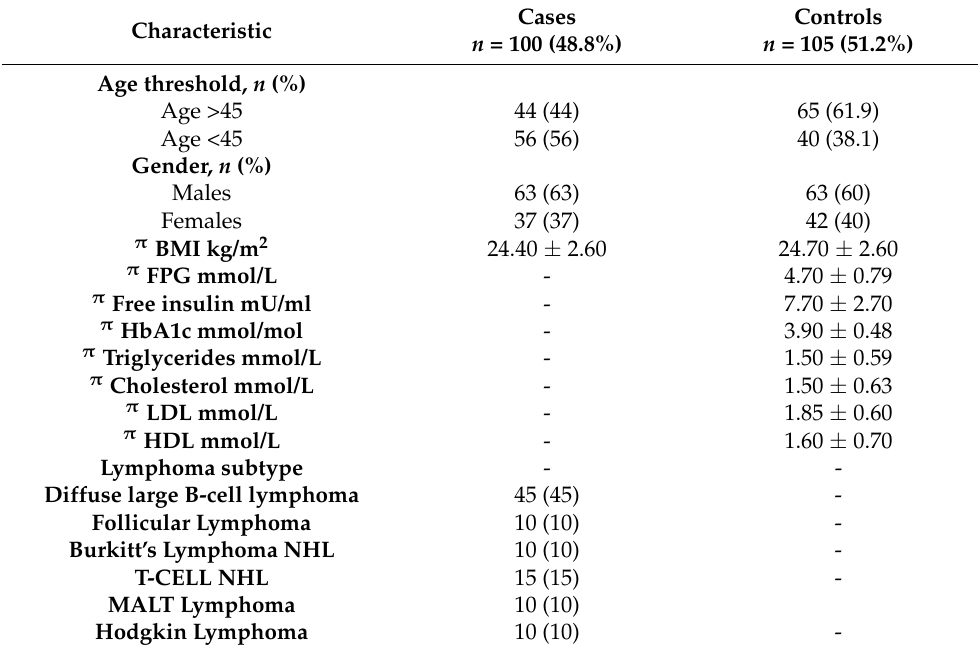
Table 1. Characteristics of study participants.